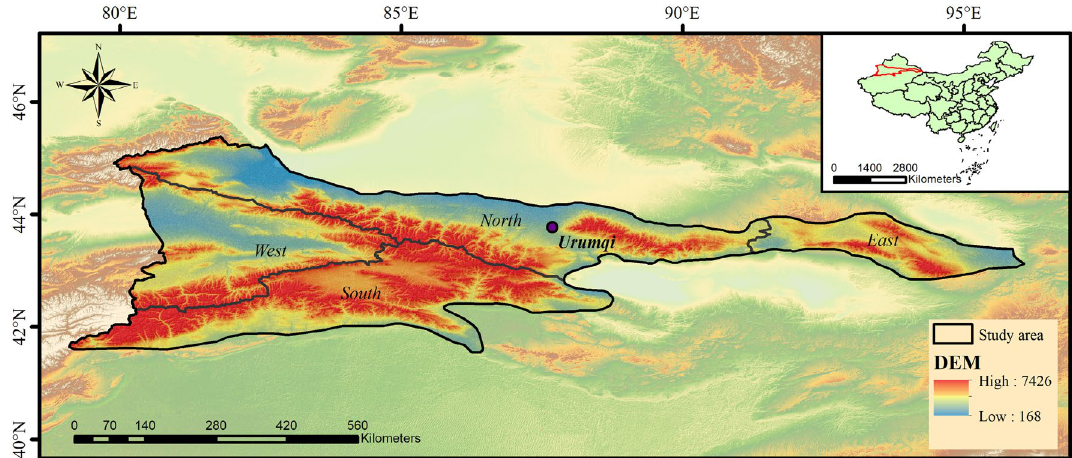
Figure 1. Study area. The maps were generated by ArcGIS 10.2, URL: http:// suppo rt. esri. com/ Produ cts/ Deskt op/ arcgis- deskt op/ arcmap/ 10-2- 2# overv